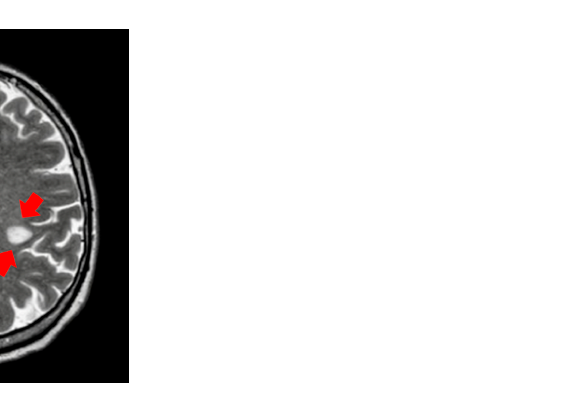
Figure 1. First brain magnetic resonance imaging showing encephalic vasculitis during sunitinib Figure 1. Firstbrainmagneticresonanceimagingshowingencephalicvasculitisduringsunitinibtreatment. treatment.